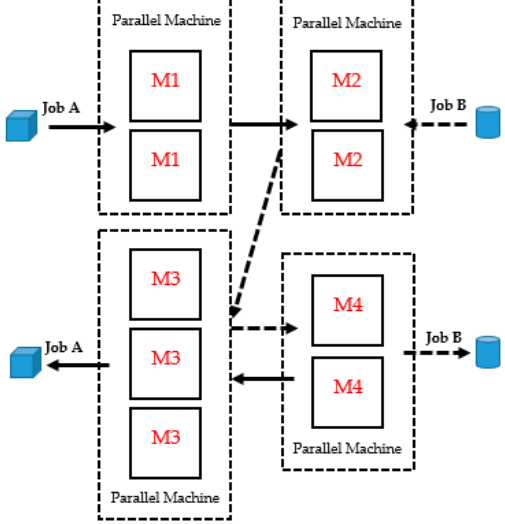
Figure 1. Flexible job shop scheduling problem pattern.